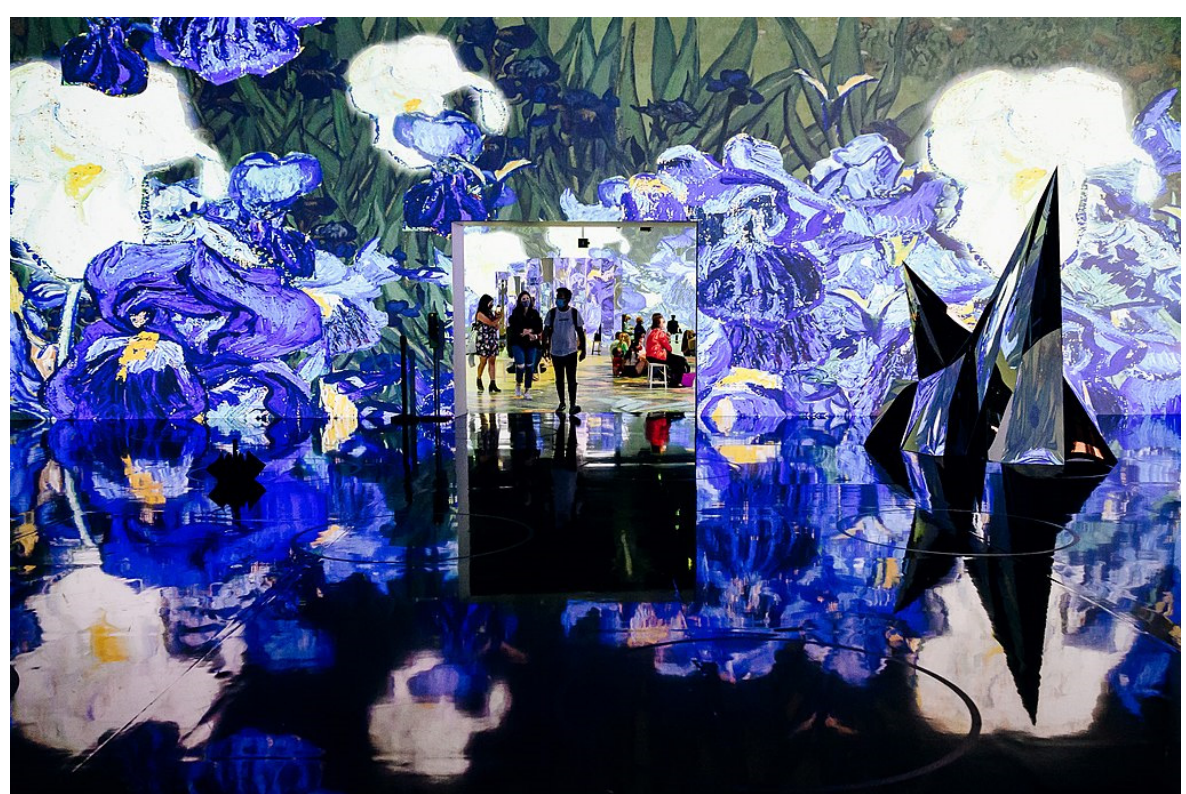
Figure 2. Installation view of Immersive Van Gogh in New York City. Photo by Nina Westervelt is